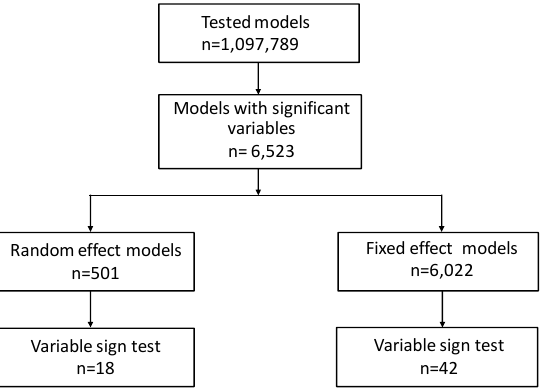
Figure 2. Results of applying the automatic model-selection technique for panel data regressions. It is observed that 1,097,789 models were tested with different combinations of variables. As a result of the significant variables, 6523 remained, which can be divided into 501 by random effects and 6022 by fixed effects. Finally, the coefficients’ signs were evaluated to be consistent with our variable of interest. Thus, as a result, 18 panel data models with random effects and 42 panel data models with fixed effects were obtained. Table 2 shows the expected signs of the coefficients of the candidate explanatory variables on the screen. In addition, this table shows the correlations between the candidate variables and the dependent variable, i.e., the NTL index [37], defined by the ratio below between the non-technical losses and the low-voltage market, both given in MWh: Non (cid:3398) technical losses of the utility 𝑖 in year 𝑡(cid:4666) MWh (cid:4667) 𝑁𝑇𝐿 (cid:3404) (cid:3036) , (cid:3047)